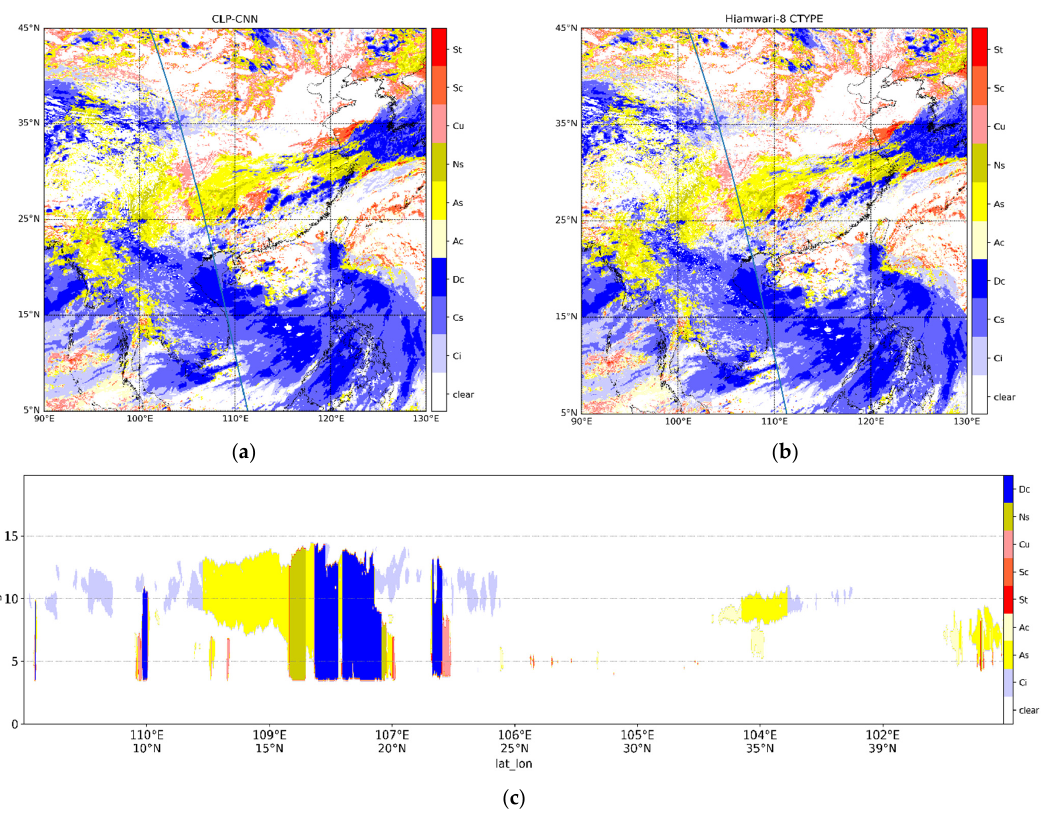
Remote Sens. 2022 , 14 , x FOR PEER REVIEW 18 of 20 Figure 12. Comparison of the CLP-CNN output and Himawari-8 product with the CloudSat 2B- Figure 12. Comparison of the CLP-CNN output and Himawari-8 product with the CloudSat 2B- CLDCLASS product. The blue line in ( a , b ) represents the satellite orbit of CloudSat; ( a ) CLP-CNN CLDCLASS product. The blue line in ( a , b ) represents the satellite orbit of CloudSat; ( a ) CLP-CNN out- scanning points closest to the point and compared with CloudSat. The comparison results output results; ( b ) Himawari-8 product; ( c ) CloudSat 2B-CLDCLASS product; (example time 20190701). put results; ( b ) Himawari-8 product; ( c ) CloudSat 2B-CLDCLASS product; (example time 20190701). were evaluated by POD. The statistical results of the evaluations are shown in Figure 13. To more clearly evaluate the accuracy of the CLP-CNN output cloud-classification results, we selected different points from the CLP-CNN output results and the Himawari- 6 products. We conducted a seasonal test using CloudSat 2B-CLDCLASS data from Janu- ary to July 2019. The selected points with different classifications were matched with CPR